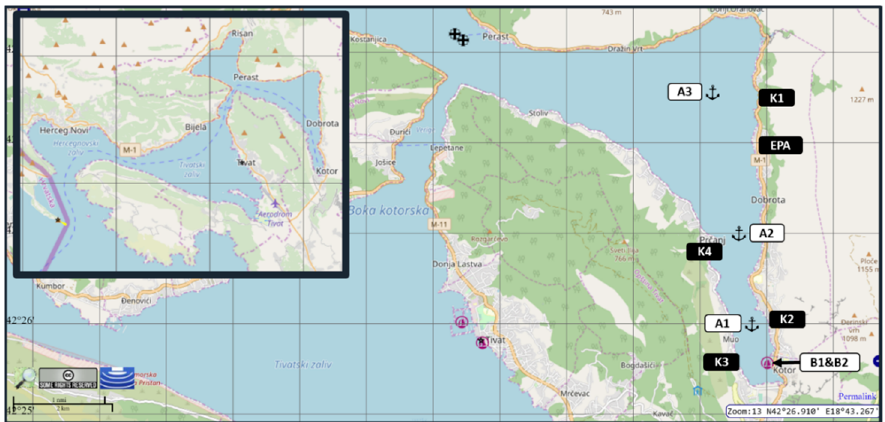
Figure 1. Map of Boka Kotorska Bay with Kotor Bay at the end with anchoring (A1–A3), berthing (B), PM measurement (K1–K4) positions, and Montenegrin EPA measuring station (EPA)